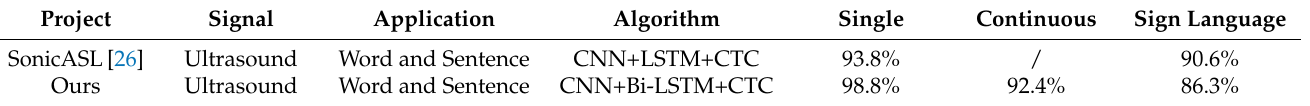
Table 2. Comparison with the sentence level